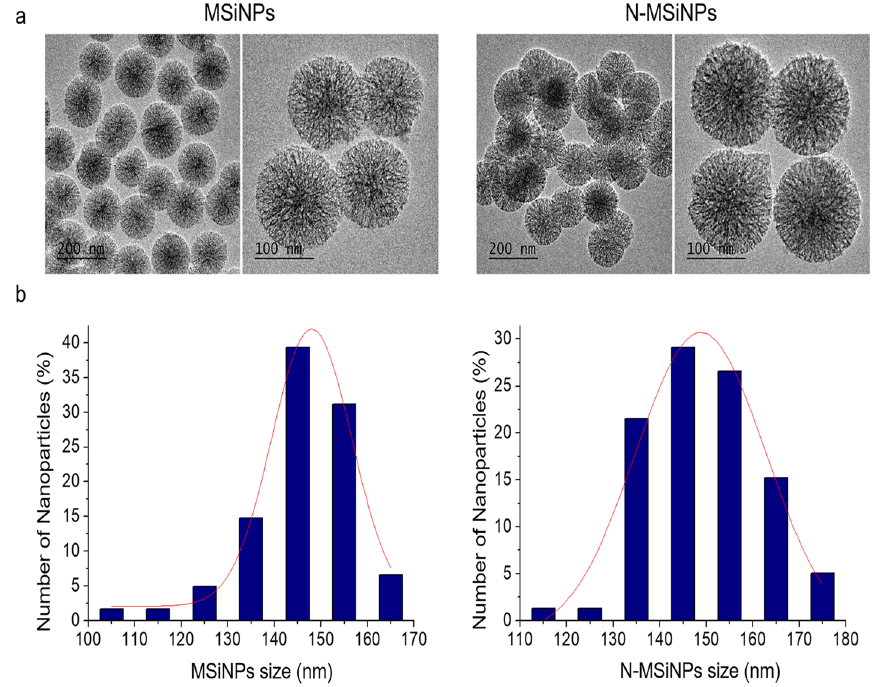
Figure 1. Nanoparticle morphology and particle size distribution; TEM images of the nanoparticles ( left ) and corresponding particle size distribution measured using micrograph image analysis ( right ): ( a ) MSiNPs and ( b ) N-MSiNPs.